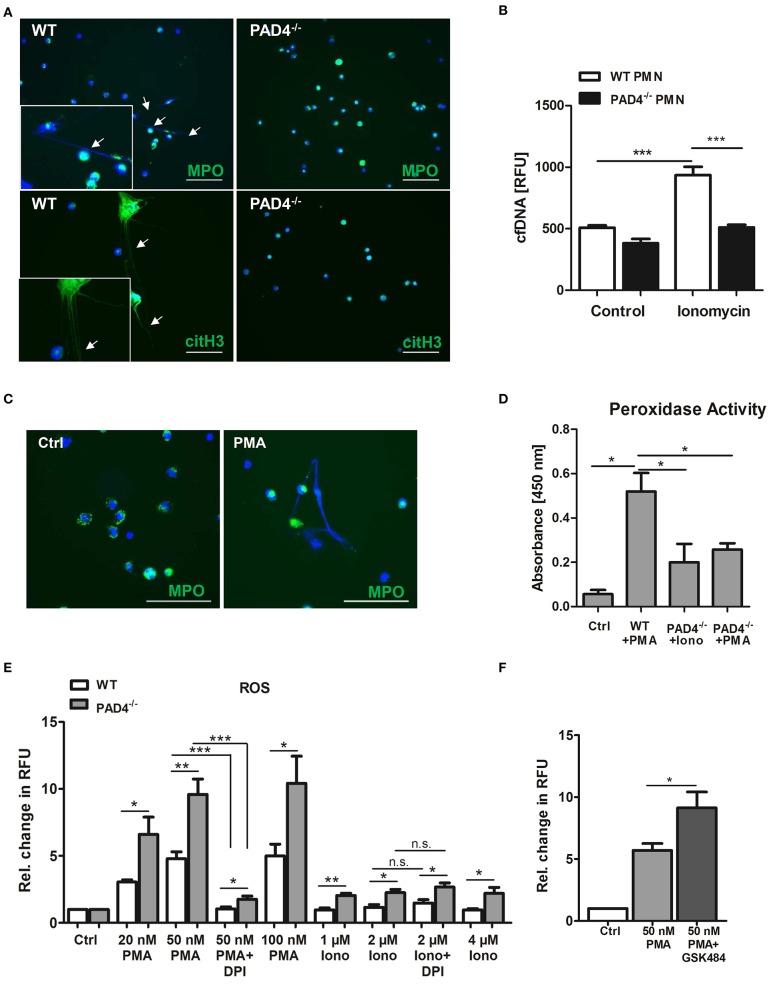
PAD4−/− neutrophils are unable to release NETs but produce high amounts of ROS. (A) Bone marrow-derived neutrophils from WT and PAD4−/− mice were seeded on coated coverslips and stimulated with 4 μM ionomycin for 3 h at 37°C. For NETs detection, cells were stained with anti-MPO antibody or anti-citrullinated histone H3 antibody (both green) and counterstained with DAPI (blue). Representative images of five independent experiments are depicted. Scale bar = 50 μm. (B) WT and PAD4−/− neutrophils were stimulated with 4 μM ionomycin for 3 h and cfDNA/NETs release in culture supernatants was quantified by Pico Green DNA staining. n = 5. ***p < 0.001. Two-way ANOVA was performed followed by Newman-Keuls post-hoc test. (C) Bone marrow-derived WT neutrophils were seeded on coverslips and stimulated with 100 nM PMA for 3 h to release NETs. NETs were detected by staining with anti-MPO antibody (green) and DAPI (blue). Representative images of three independent experiments are shown. Arrow heads indicate NETs formation. Scale bar = 50 μm. (D) Peroxidase activity in supernatants collected from WT neutrophils stimulated with PMA (100 nM) and from PAD4−/− neutrophils stimulated with PMA or ionomycin (4 μM), respectively, was quantified by the addition of TMB substrate and absorbance measurement. n = 3. *p < 0.05. Two-way ANOVA was performed followed by Newman-Keuls post-hoc test. (E) Bone marrow-derived neutrophils (3 × 105) from WT and PAD4−/− mice were stimulated with the indicated concentrations of PMA and ionomycin for 3 h. In some experiments, cells were pre-incubated with DPI (10 μM) for 20 min. Then, DHR-123 (20 μM) was added and cells were incubated for additional 15 min at 37°C under shaking. Relative change in RFU compared to unstimulated control samples is depicted. n = 4. *p < 0.05; **p < 0.01; ***p < 0.001 determined by the Student t-test. (F) Bone marrow-derived WT neutrophils (4 × 105) were pre-cultured in the presence of GSK484 for 20 min before stimulation with 50 nM PMA for 3 h. After addition of DHR-123, cells were further incubated for 15 min under shaking at 37°C. Fluorescence of Rhodamine-123 was measured with a microplate reader. Relative change in RFU is depicted. *p < 0.05 determined by the Student t-test.